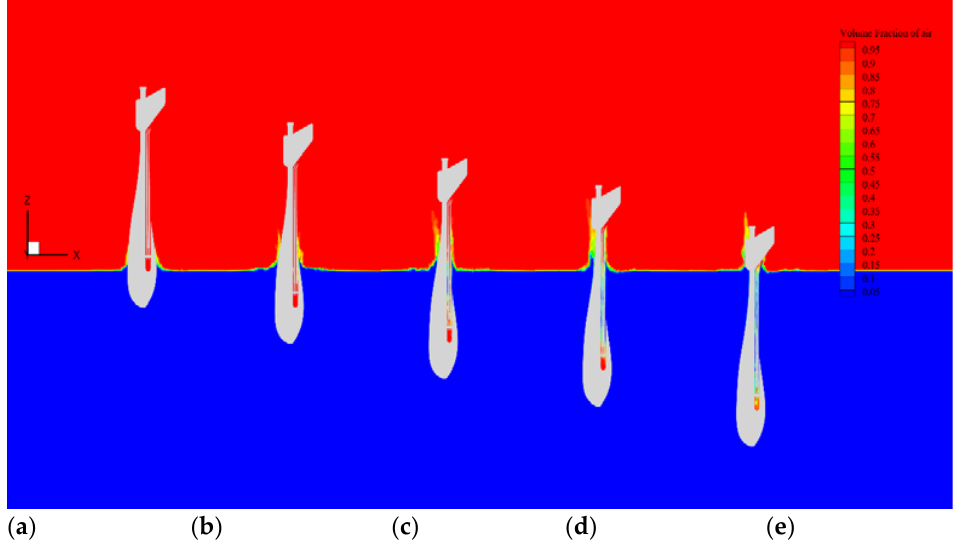
Figure 9. Free surface profiles of the UAUV entering water at W s = 12.0 m/s at different times: ( a ) t = 0.04 s, ( b ) t = 0.06 s, ( c ) t = 0.08 s, ( d ) t = 0.08 s, and ( e ) t = 0.12 s.